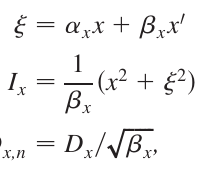
FIG. 3. Longitudinal-horizontal coupling effect in a primary momentum scraper (a) at the scraper; (b) at a dispersion-free location; CSNS RCS lattice, carbon foil of 0.05 mm, at energy of 80 MeV, with a momentum deviation of 1.0%.